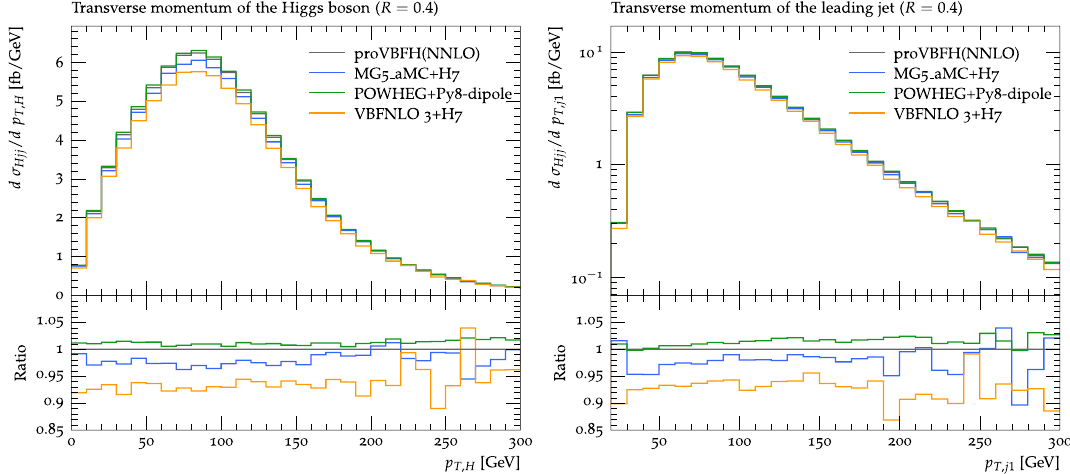
Fig. 12 Transverse-momentum distribution of the Higgs boson (left) and of the hardest tagging jet (right) within the cuts of Eqs. (3)–(4) at NLO + PS accuracy for the MadGraph5_aMC- @NLO , POWHEG-BOX , and VBFNLO + Herwig7/Matchbox gener-